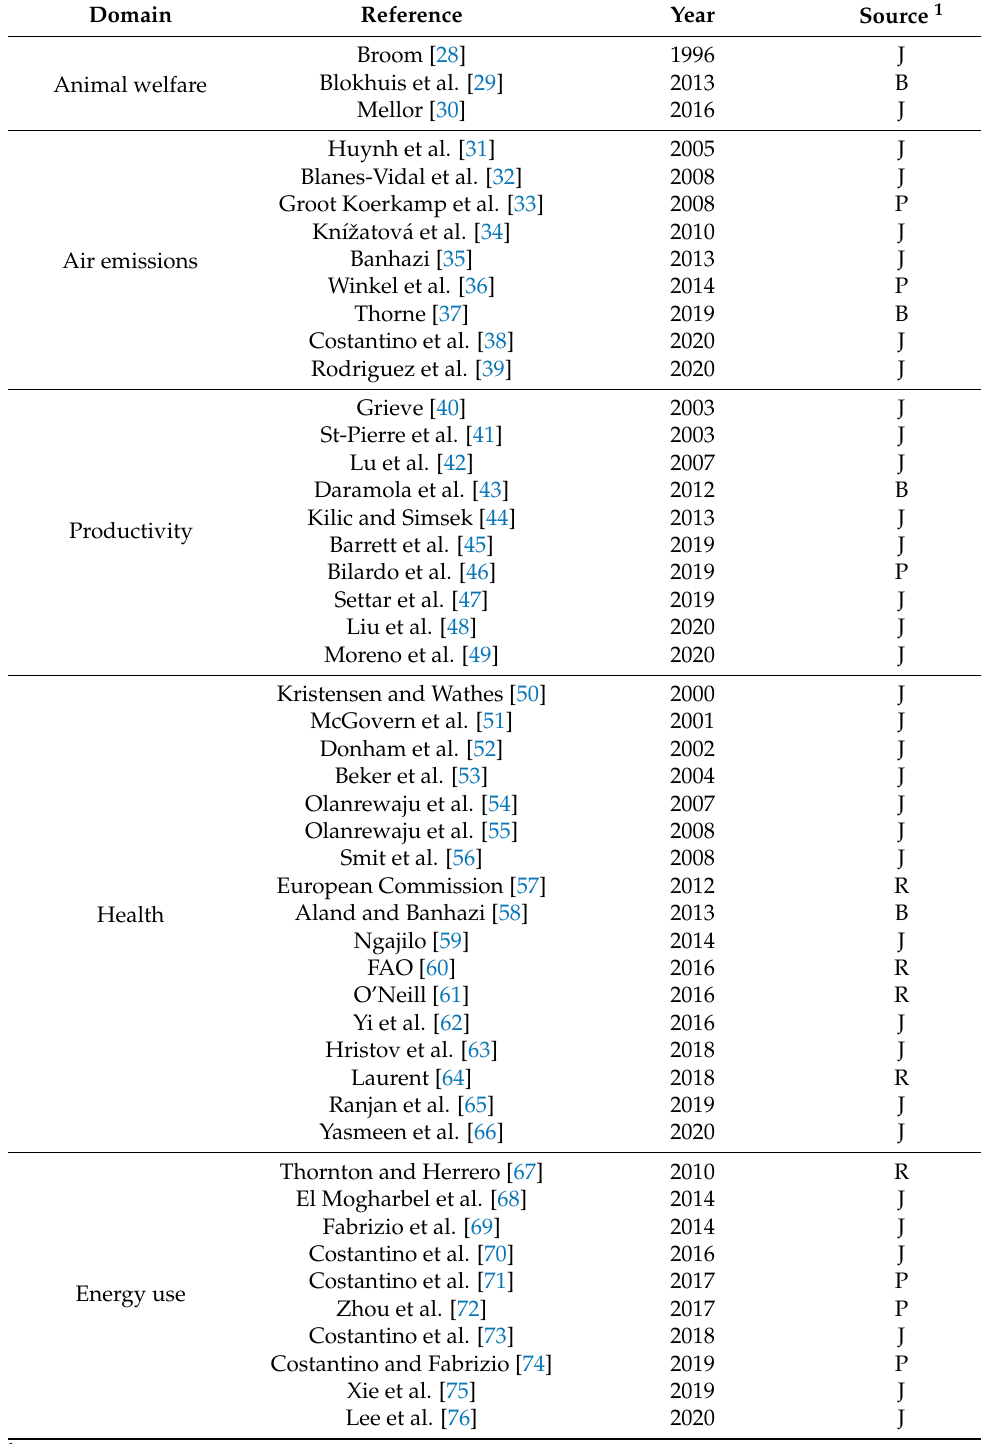
Table 1. Domains of livestock production that have a mutual relation with climate control and scientific works from literature—with publication year and type of source—that highlight that mutual